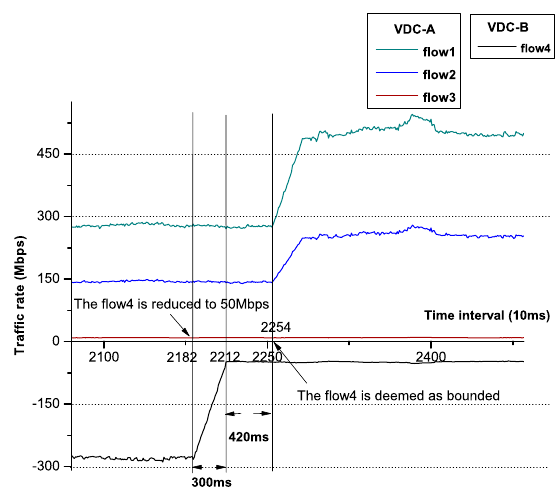
Figure 13. The detailed variation of flow rates in [t2, t3].